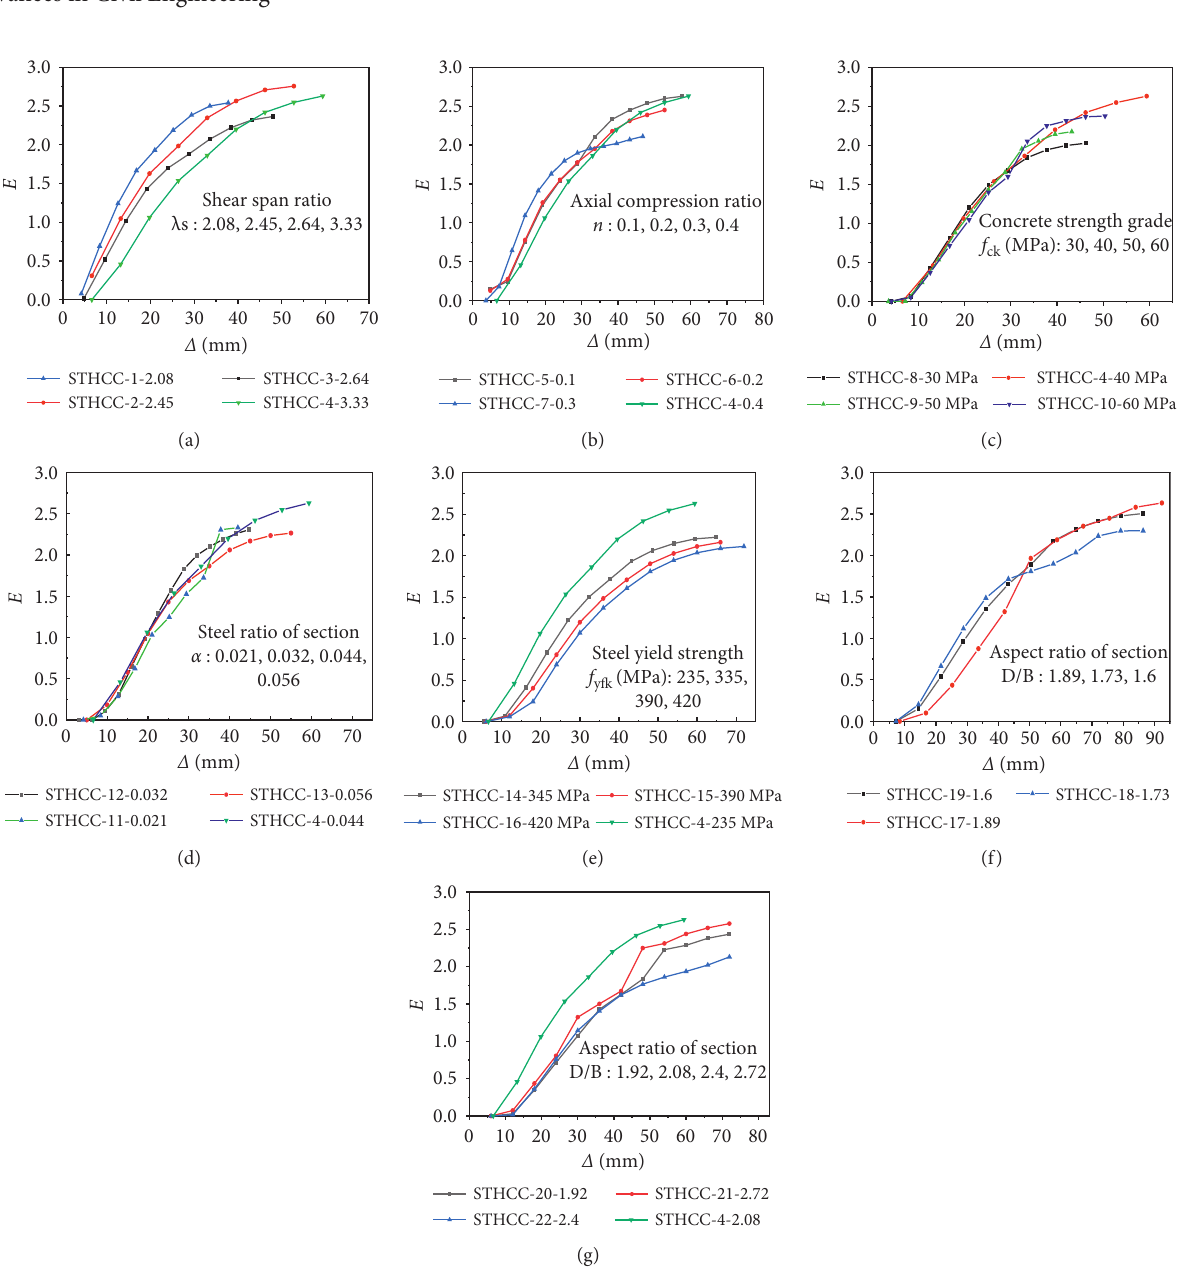
s : 2.08, 2.45, 2.64, 3.33. (b) n : 0.1, 0.2, 0.3, 0.4. (c) f ck :